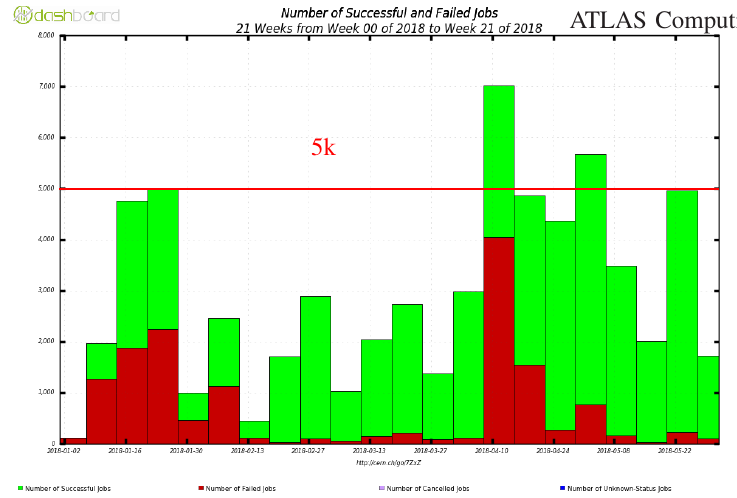
Figure 6. Number of finished and failed job every week